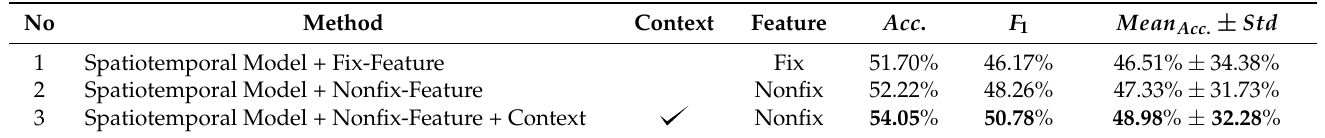
Table 3. Performance results of the spatiotemporal models on the AFEW validation